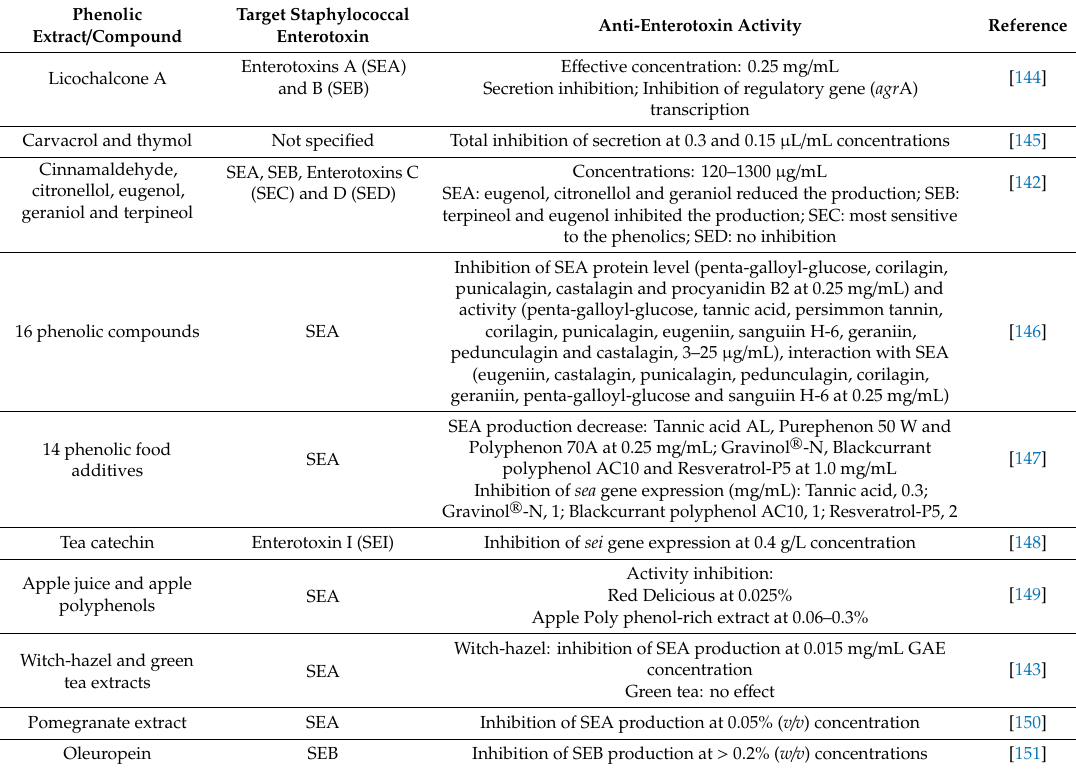
Table 5. Anti-staphylococcal enterotoxin e ff ect of plant phenolic extracts and